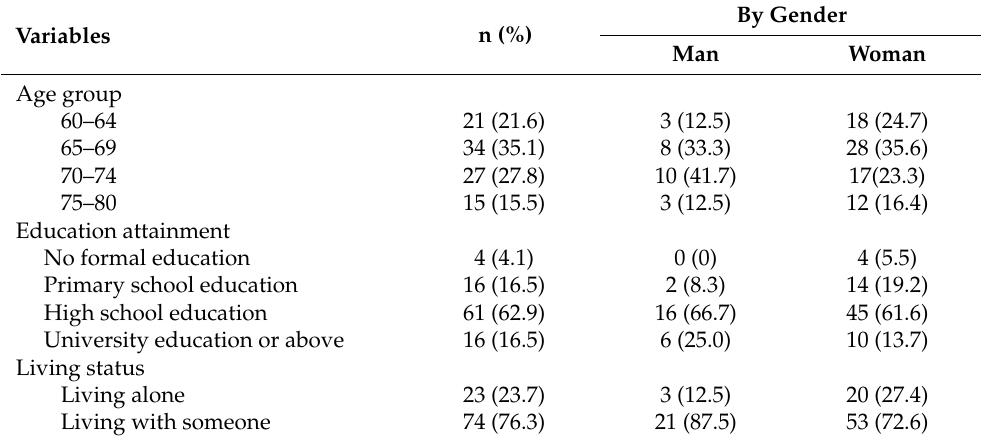
Table 2. Sociodemographic characteristics of participants.